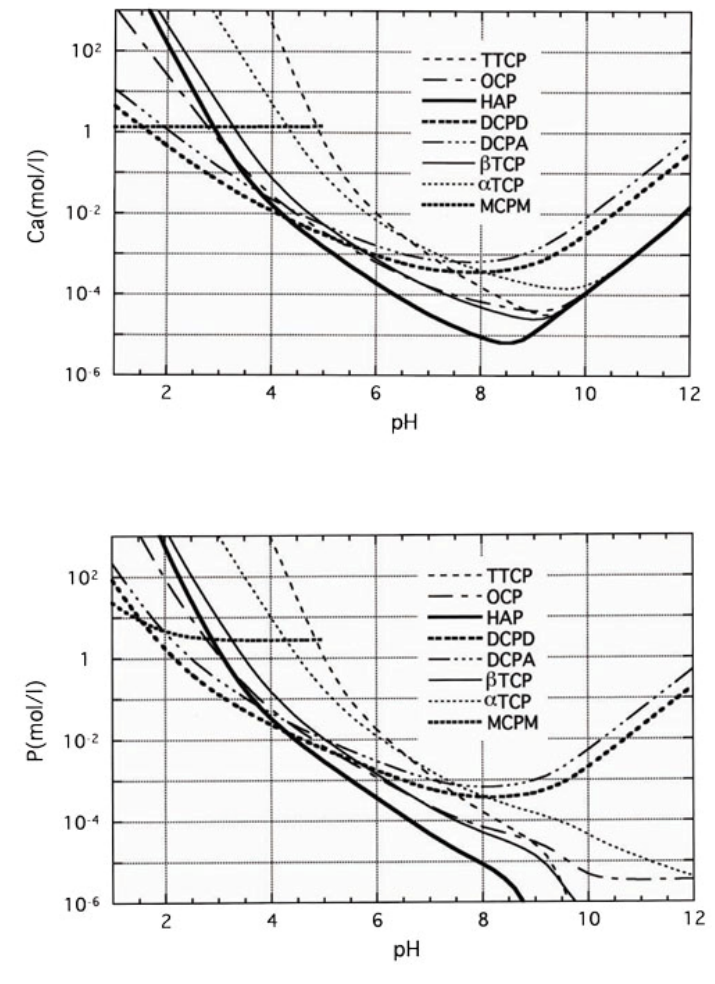
Figure 6. Solubility of Ca and P in various calcium phosphate compounds plotted against the pH calculated from their solubility products